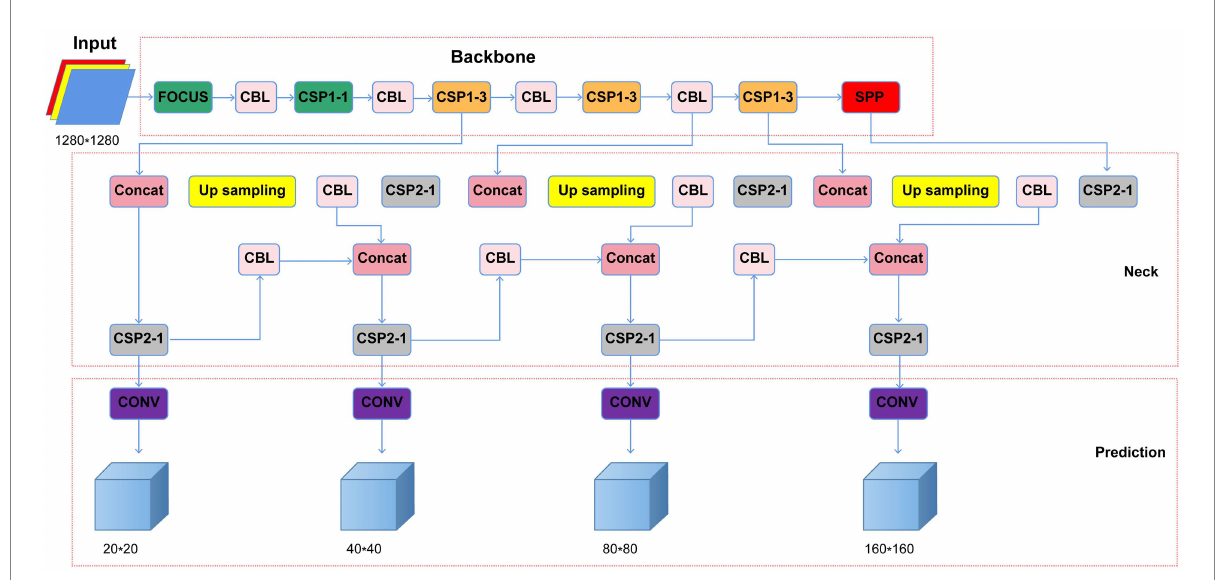
FIGURE 1 Optimized YOLO v5 network structure (CBL, Conv+Bn + Leaky-relu; CSP, cross stage partial network; Concat, concatenate function; Conv, convolutional layer; SPP, spatial pyramid